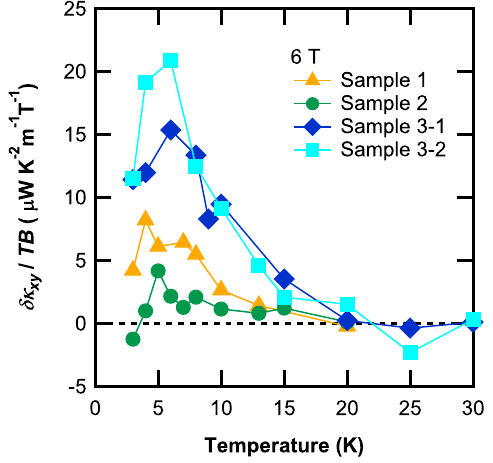
=TB at 6 T of all xy